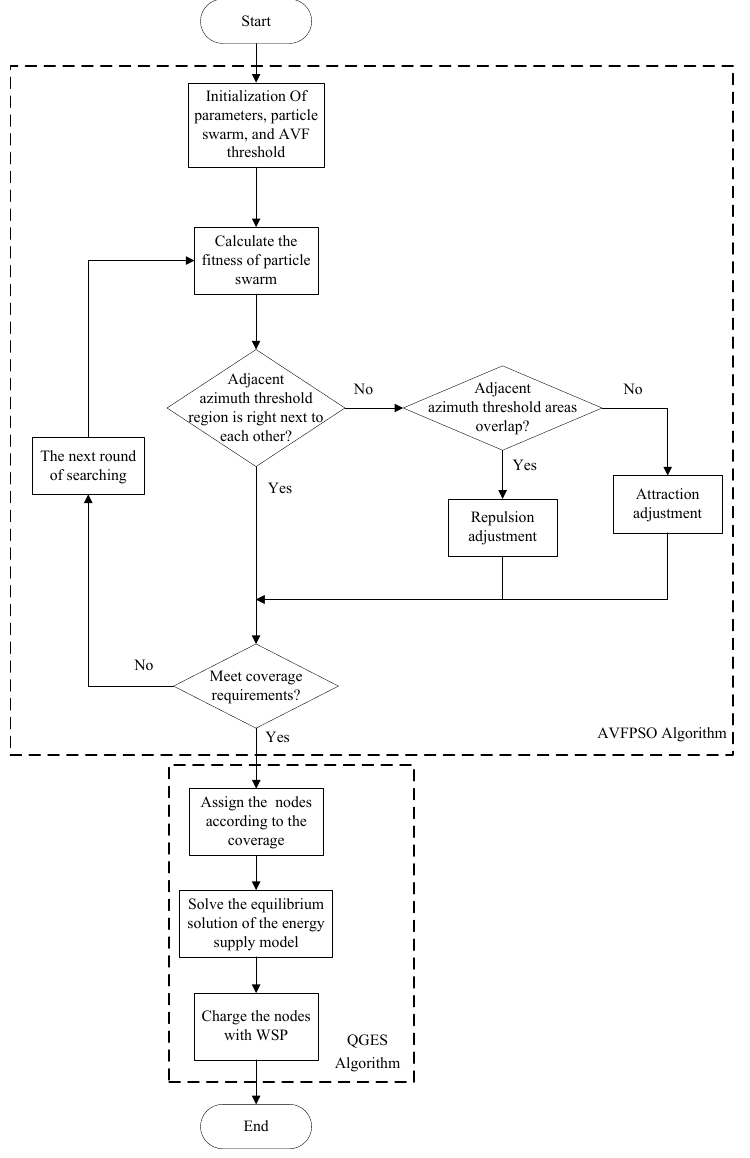
Figure 5. The flow of the TPEM